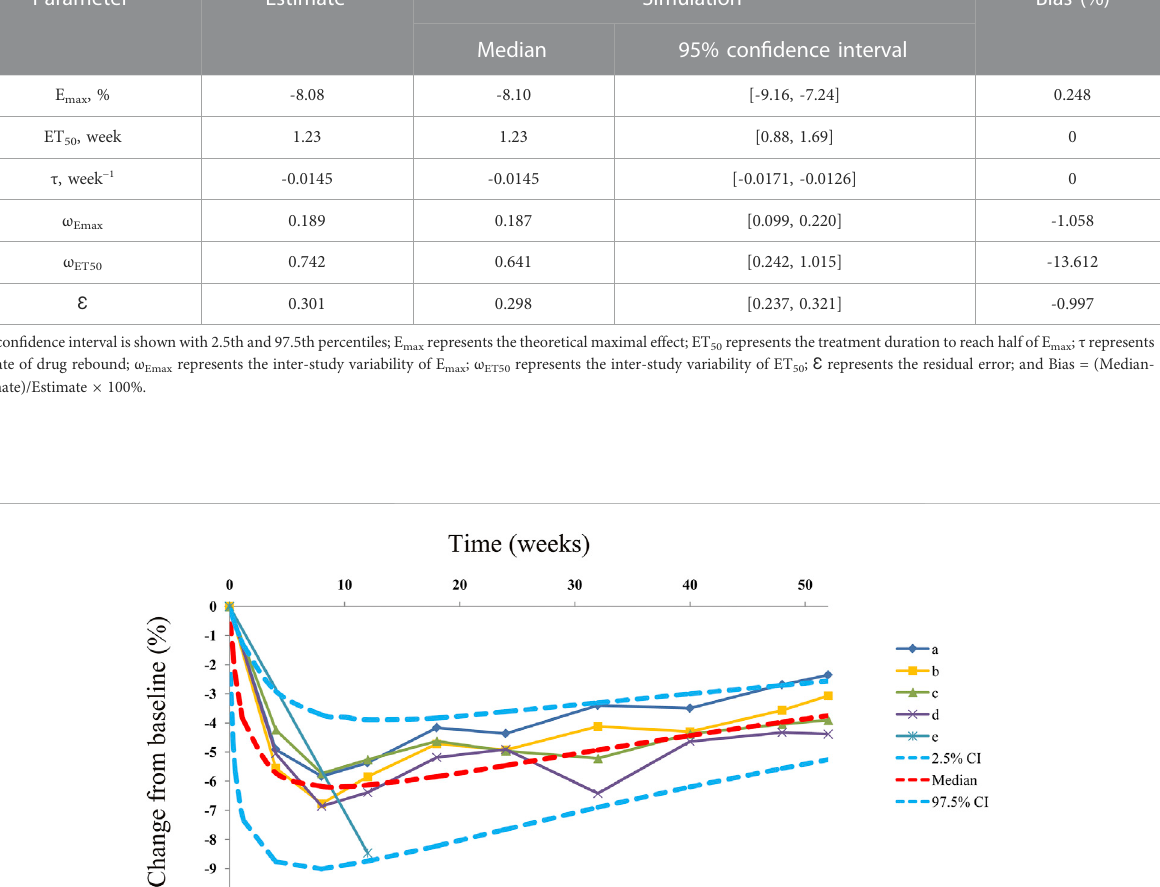
TABLE 1 Parameter estimates of the fi nal model and 95% con fi dence interval. Parameter